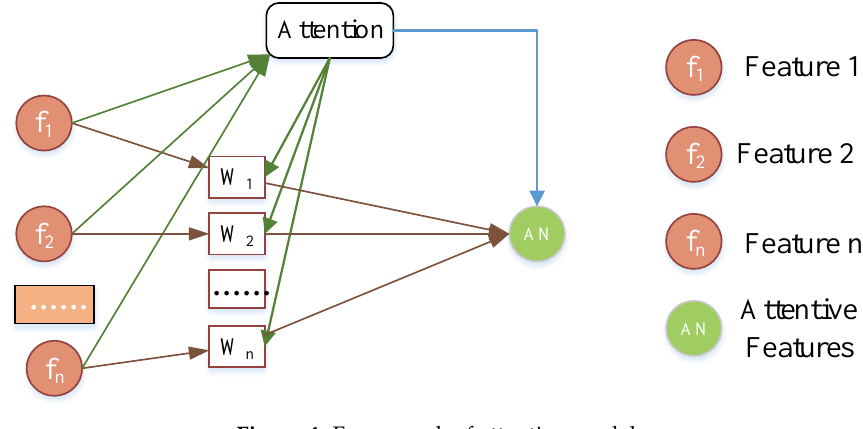
Figure 4. Framework of attention model.